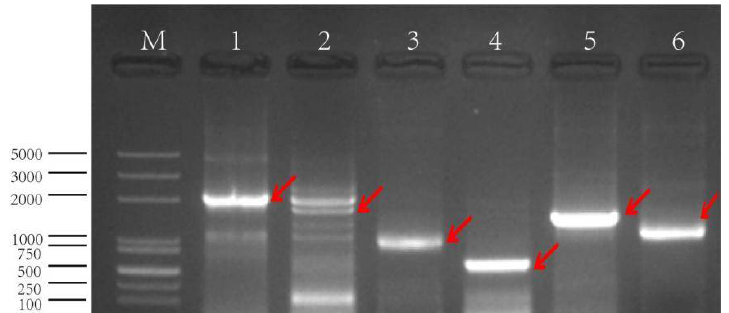
Figure 4. The PCR amplification of promoter GSX7R and its deletions. M: M5 DL2000 plus DNA marker, 1: GSX7R-2097, 2: GSX7R-1765, 3: GSX7R-1198, 4: GSX7R-554, 5: GSX7R-1543, 6: GSX7R- 1212. The amplified bands are indicated by red arrows.